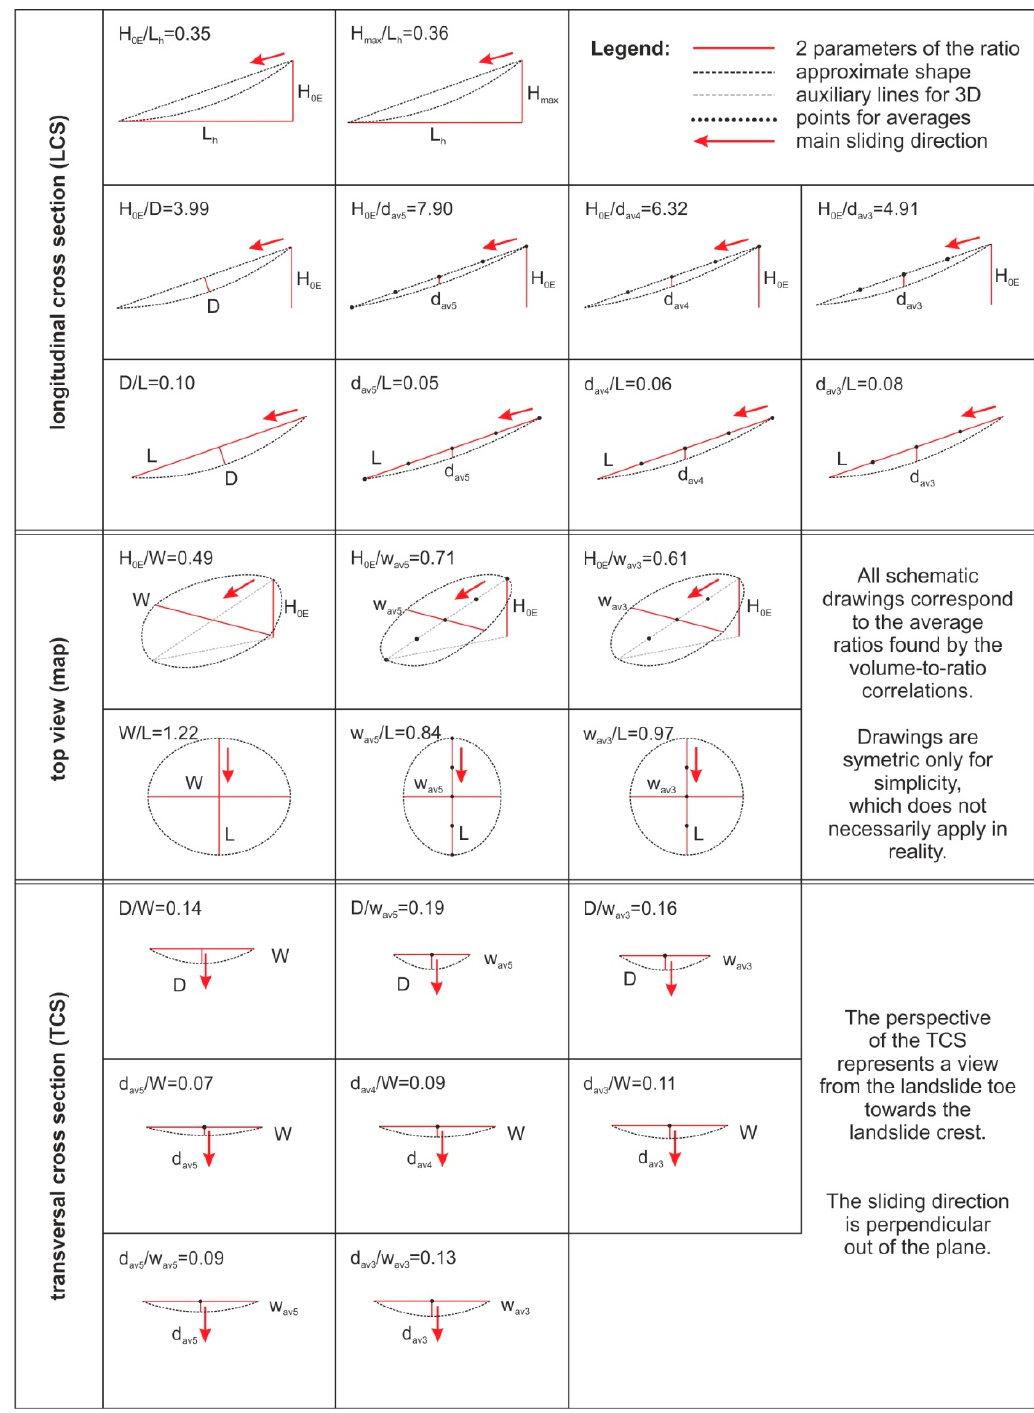
Figure 10. Schematic representation of ratios of dimension-related parameters. All schematic drawings correspond to the average ratios found by the volume-to-ratio-correlation shown in Table 6c. Table 7. Ratios per volume group as reported in Domej et al. [31]. The value triplets correspond to the ratios per tested set (“full” ( a ), “SR” ( b ), and “EQt” ( c )). Ratios in Domej et al. [31]